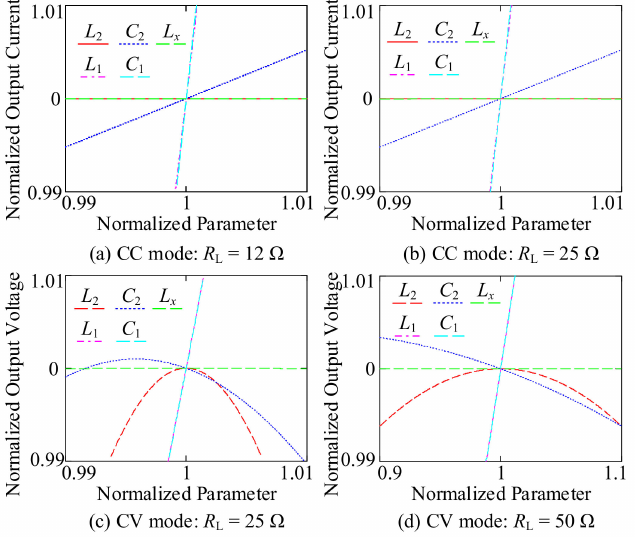
Figure 20. Output current or voltage versus normalized parameters at two charging modes and two loading conditions.